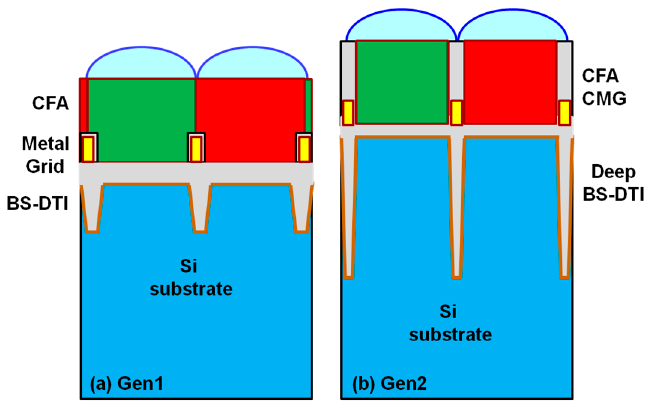
Figure 3. Gen1 ( a ) and Gen2 ( b ) schematic; Gen2 BSI stack has thicker silicon, narrower and deeper BS-DTI, and a composite metal-oxide, back-side grid.